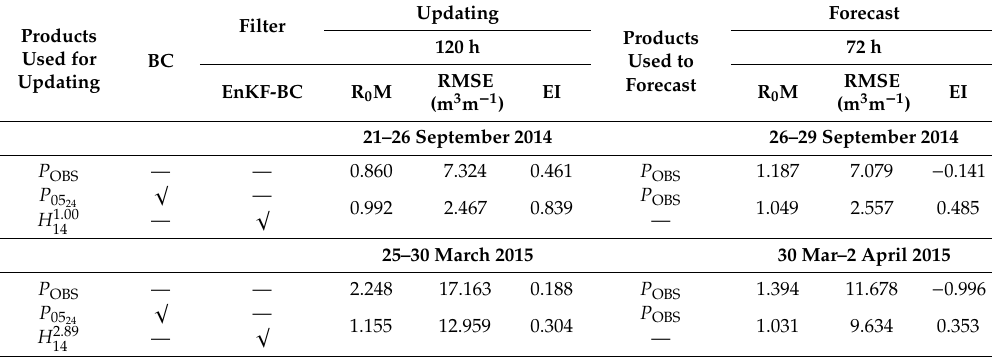
Figure 7. The comparison of Q OBS (observed flow; dashed blue line with double dots), Q HBV (HBV product for P OBS ; dashed green line), Q HBV − BC (HBV product for P BC and for H 2.89 − BC without assimilation; dashed black line), avg. Q HBV − BC − EnKF (averaged HBV product for P BC with assimilation the H 2.89 using EnKF filter; solid orange line) and avg. Q HBC − BC − EnKF − BC (averaged HBV product for P BC with assimilation the H 2.89 using EnKF-BC filter; solid red line), and θ HBV (HBV soil moisture product; dashed green line), H 2.89 − BC (corrected satellite soil moisture product; dashed black line), avg. H 2.89 (perturbed) (averaged ensemble of perturbed H 2.89 without BC method, solid orange line) with avg. H 2.89 − BC (perturbed) (averaged ensemble of perturbed H 2.89 with BC method; solid red line) in the Sola Basin at Zywiec in the winter period from 06:00H, 1 November 2014 to 23:00H, 30 April 2015. Table 4. Comparison of the accuracy of the HBV simulation in forecast mode both with and without updating for: P BC and the assimilation of H 1.00 or H 2.89 using EnKF-BC (the ensemble Kalman filter 05 24 14 14 with bias correction), R 0 M (ratio of means), RMSE (root mean squared error) and EI (Nash-Sutcli ff e e ffi ciency